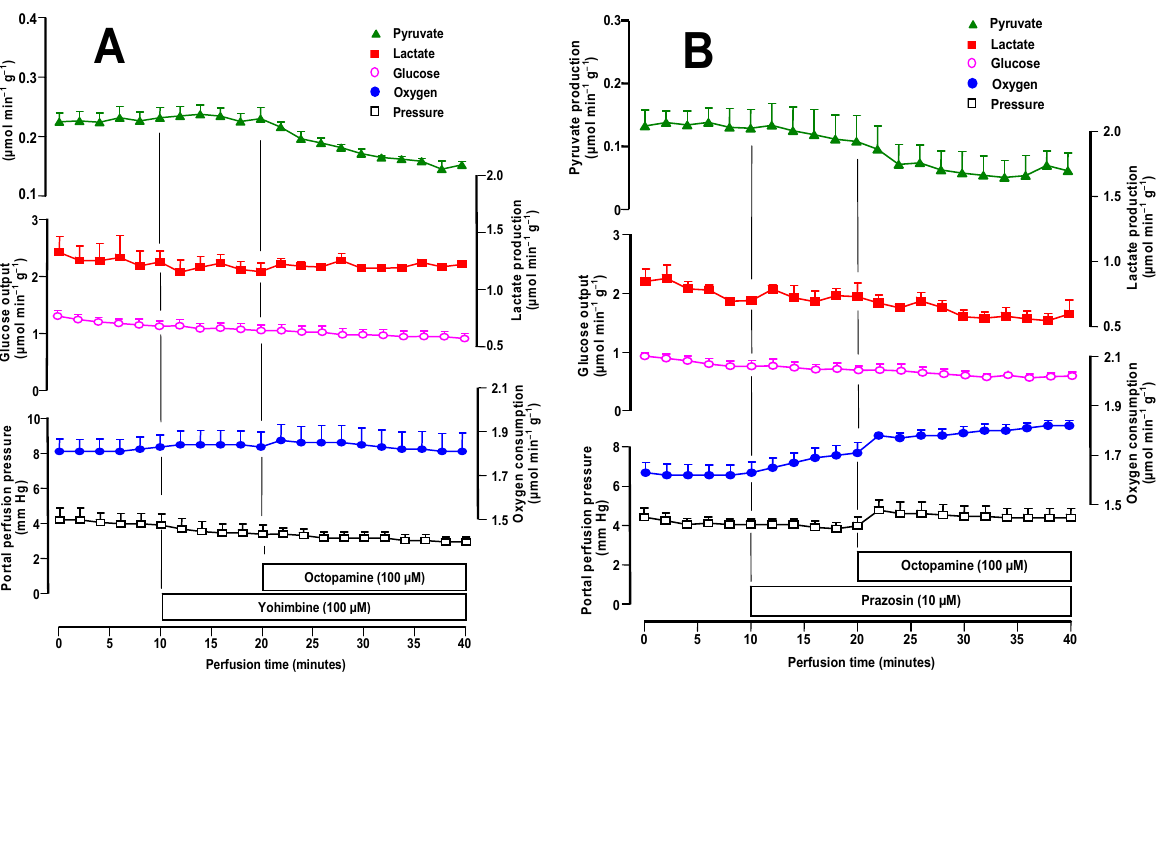
Figure 4. Influence of yohimbine ( Panel A ) and prazosin ( Panel B ) on the metabolic and hemodynamic effects of octopamine in livers from fed rats. Livers were perfused as described in Materials and Methods. The experimental protocols and the portal concentrations of yohimbine, prazosin and octopamine are indicated by the bars just above the time scale. Datum points are means ± mean standard errors of 3 liver perfusion experiments.